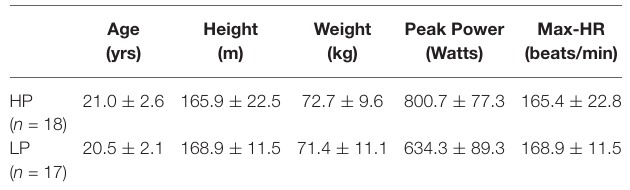
TABLE 1 | Ages, heights, body weights, peak powers and maximal heart rates (Max-HR) of low performers (LP) and high performers (HP) groups were presented as mean ±